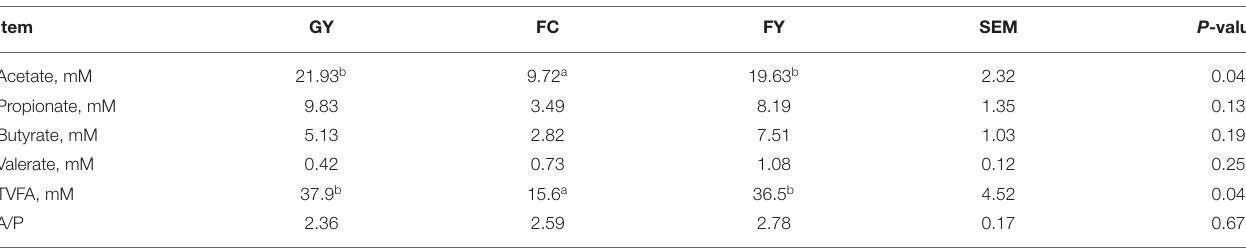
TABLE 3 | Rumen volatile fatty acids (VFAs) of GYs, FC, and